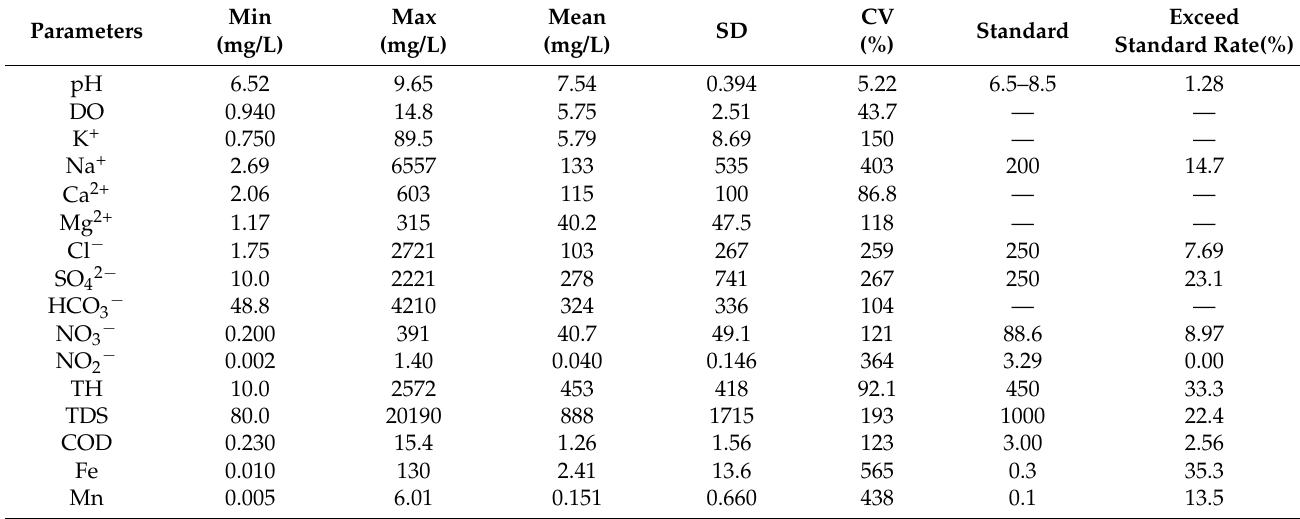
Table 2. Summary of groundwater chemical indicators in Huangshui River